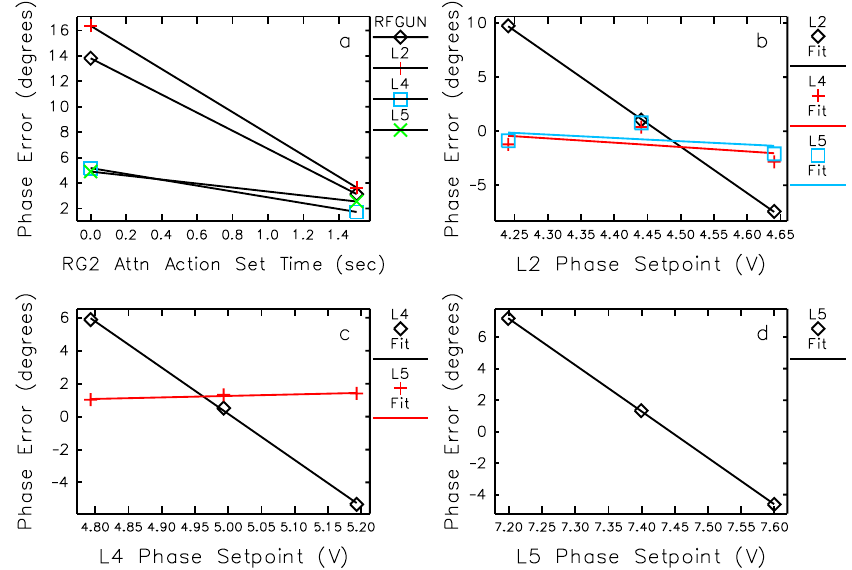
FIG. 7. (Color) Response data for all four phase detectors. The first plot (a) shows the response of all four phase detectors to a change in the rf gun 2 power. The rf gun power is changed by setting a time variable that permits an attenuator motor to move a given period of time. Plots (b), (c), and (d) show only the L2, L4, and L5 phase detectors vs the L2, L4, or L5 phase setpoint actuator. The data were all taken with the beam at its nominal phase for sectors L2, L4, and L5 and nominal rf gun 2